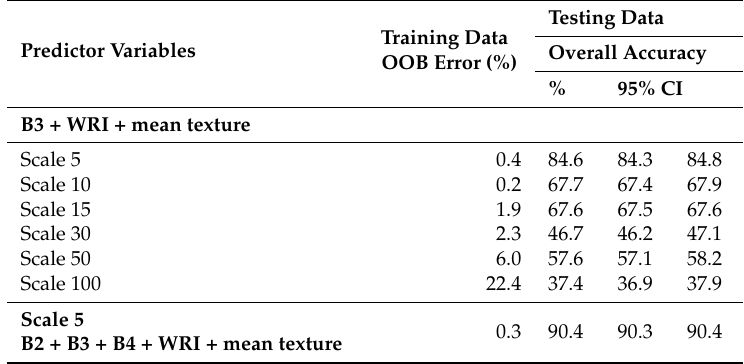
Table 8. Object-based random forest classification accuracy on training and testing datasets with various input variable combinations. Quickbird bands 2, 3, and 4 are represented as B2, B3, and B4, respectively; also included are WRI (Water Ratio Index) and mean